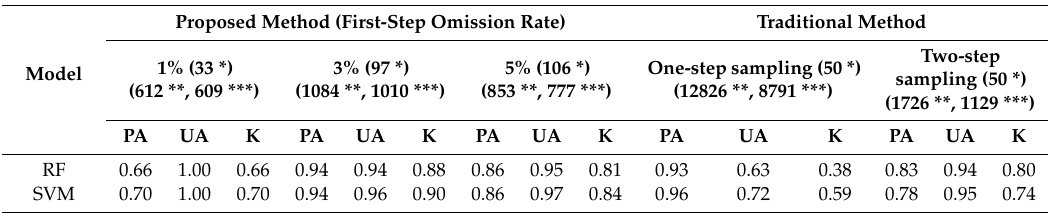
Table 5. Classification accuracy of kudzu on validation dataset by random forest (RF) and support vector machine (SVM)